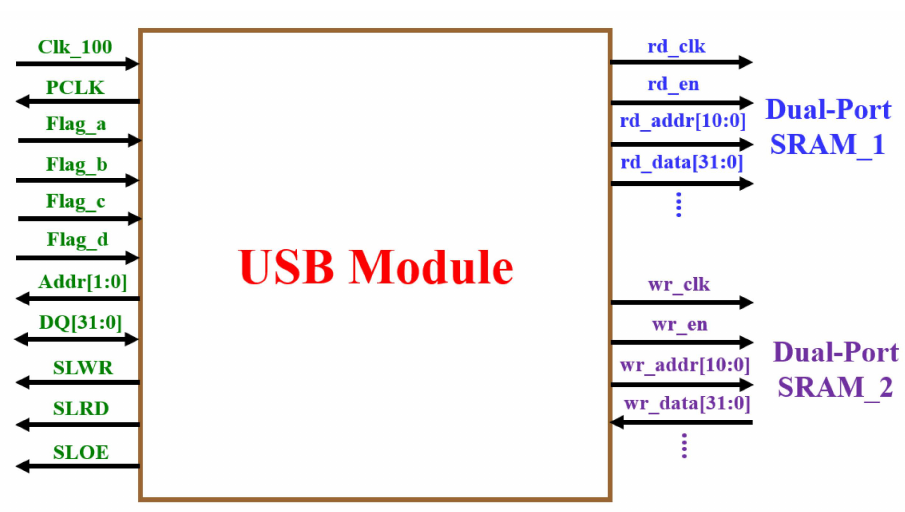
Figure 4. Architecture diagram of the designed USB